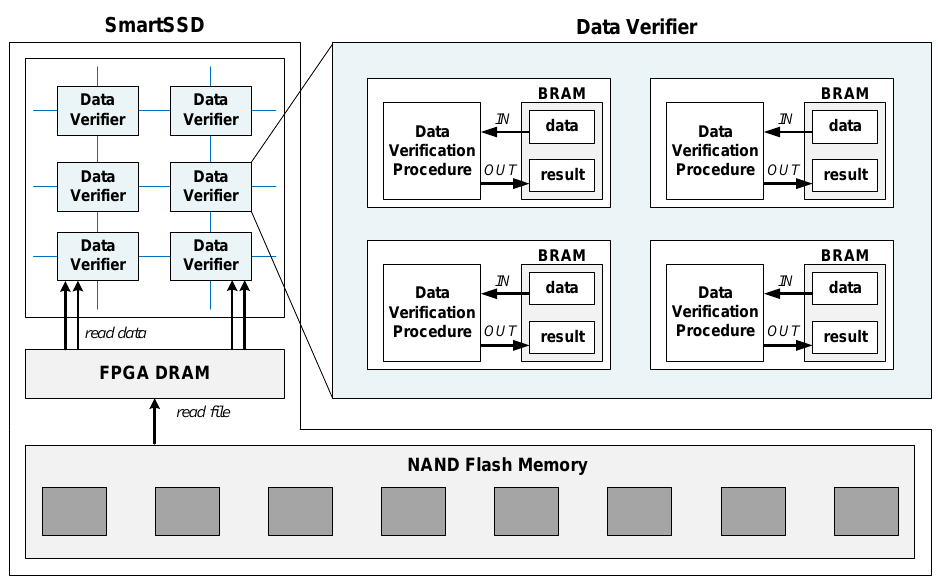
Figure 6. Overall architecture.